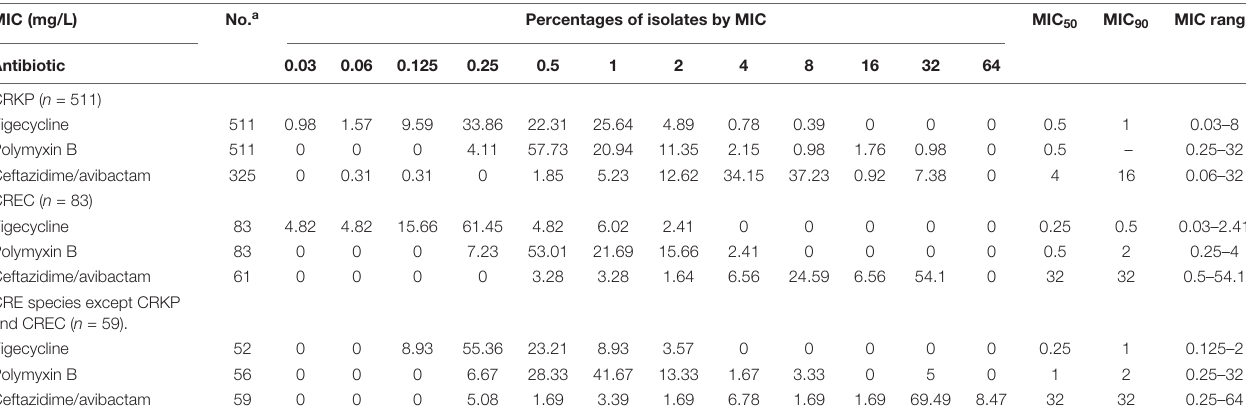
TABLE 3 | MIC distributions for antimicrobials against all CRE isolated from blood specimens in China during 2018–2019. MIC (mg/L) No. a Percentages of isolates by MIC Antibiotic CRE ( n = 653) Polymyxin B 650